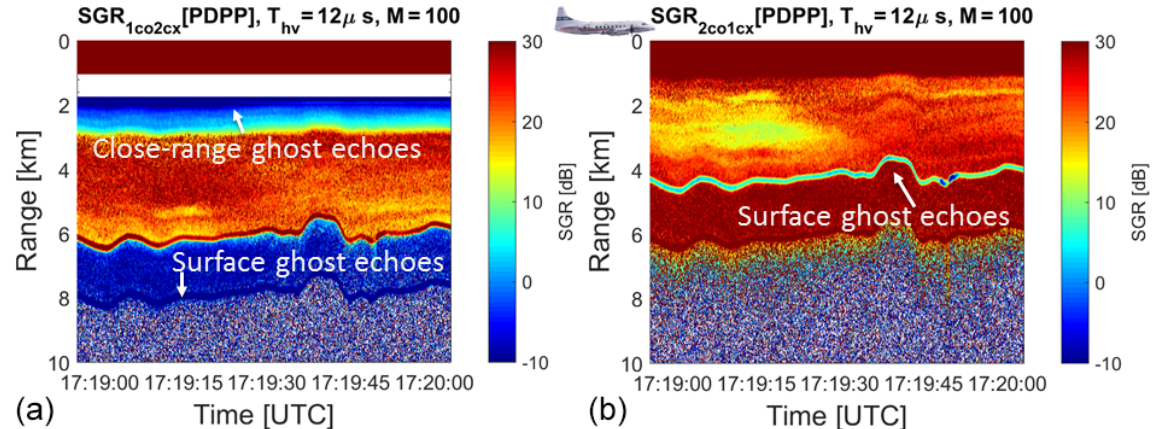
Figure 10. Signal-to-ghost ratios as defined by Eqs. (4)–(5). Areas with blue colours will have a significant reduction in Doppler accuracy due to the additional noise produced by the ghosts. Note on the right panel the extended area of small SGR caused by the interference of cross-polar signal at very short ranges.